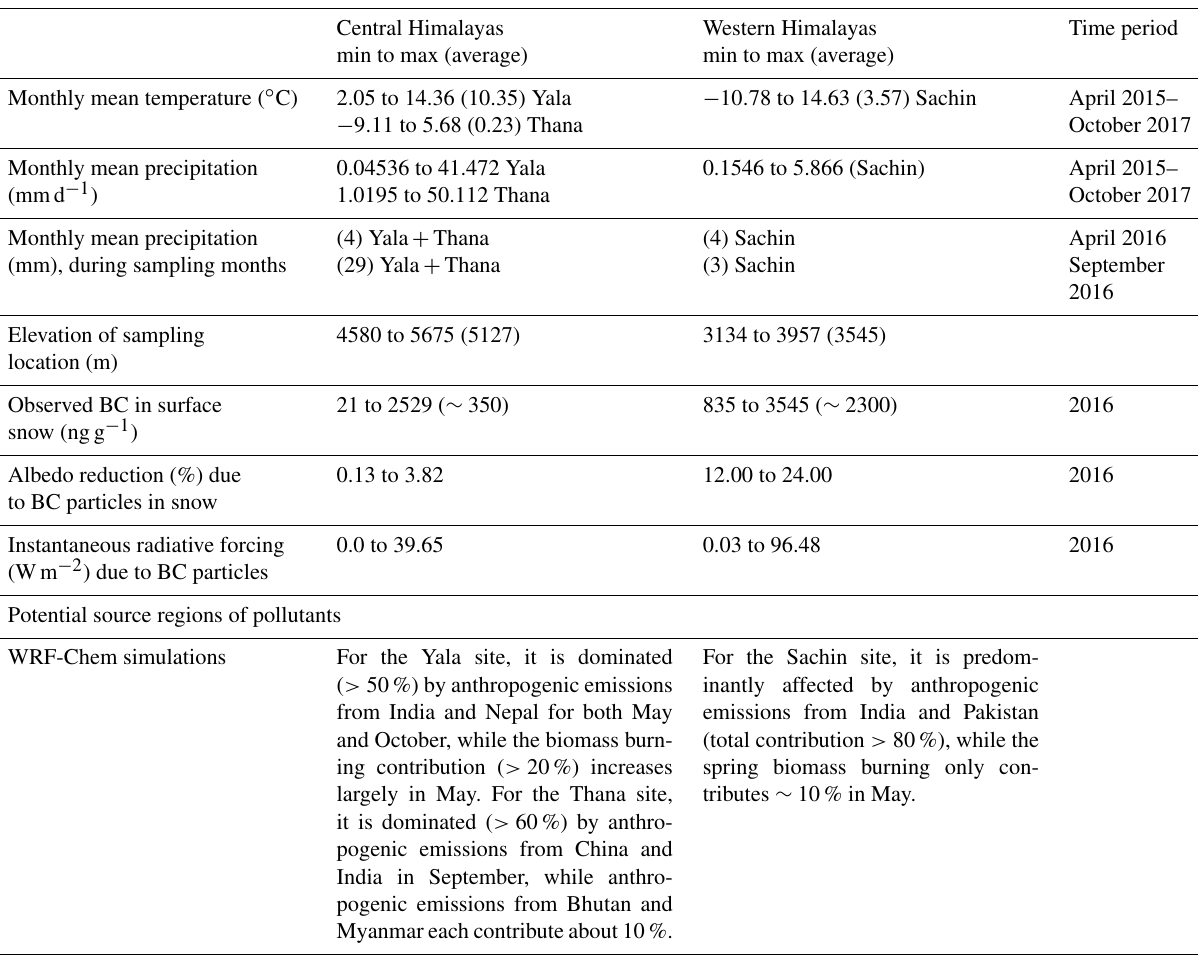
Table 2. Comparison of BC mass concentration, albedo reduction, radiative forcing, and potential source regions of pollutants for central and western Himalayan glaciers during the study